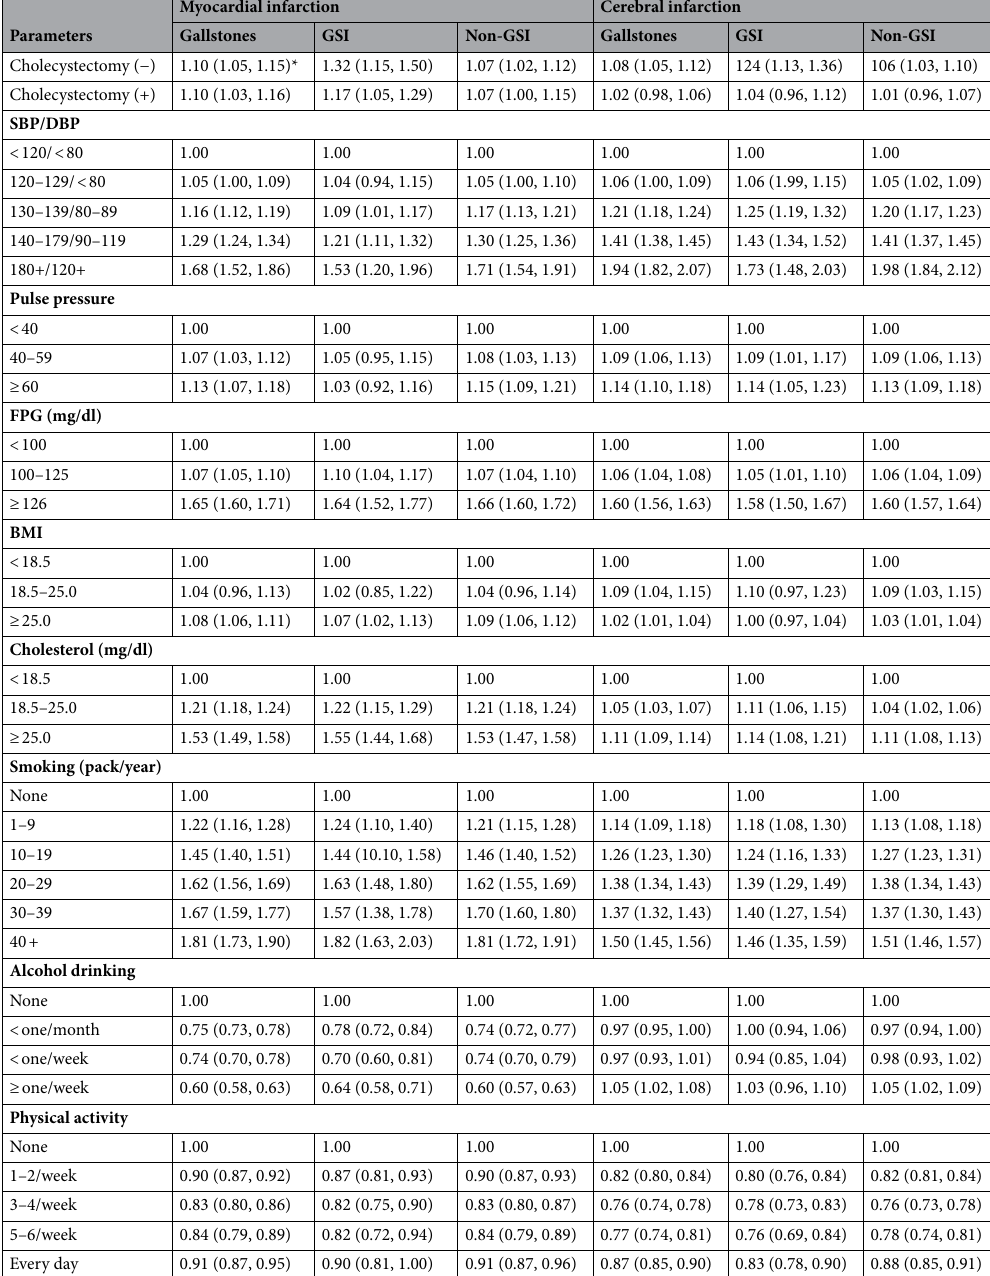
Table 3. Multivariate Cox regression analysis of risk factors associated with development of myocardial infarction and cerebral infarction. *, hazard ratio (95% confidence interval); †, number in parenthesis means the amount of alcohol consumption in women; GSI, gallstone-related infection; SBP/DBP, systolic blood pressure/diastolic blood pressure; BMI, body mass index; FPG, fasting plasma